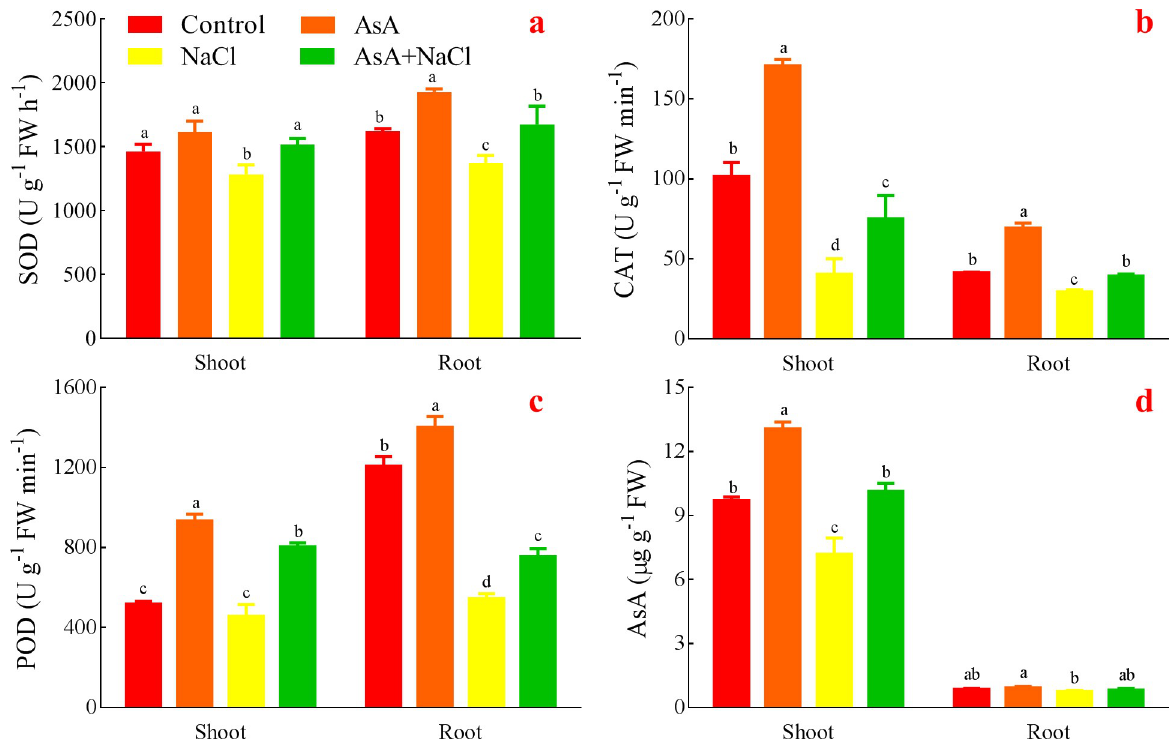
Fig 6. Effects of AsA on SOD (a), CAT (b), POD (c), and endogenous AsA (d).